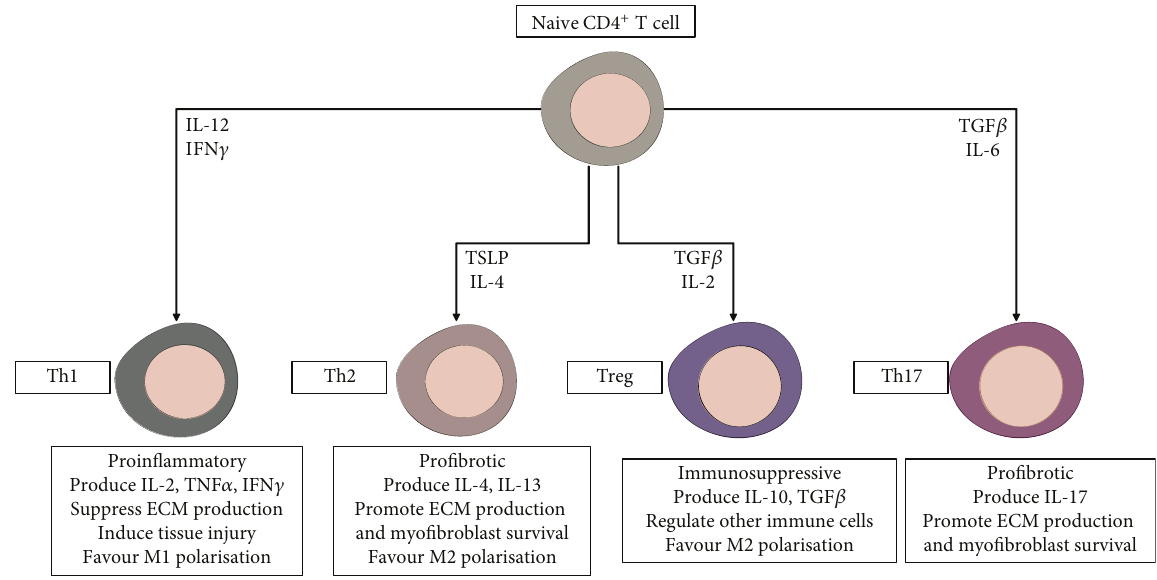
Figure 4: Functions of CD4 + T-cell subsets in liver fi brosis. The di ff erentiation of naive CD4 + T cells into distinct functional subtypes is driven by factors produced by injured parenchymal cells and other in fl ammatory cells, namely, macrophages. Tregs suppress other T-cell subsets and limit the magnitude of in fl ammation and fi brosis during tissue